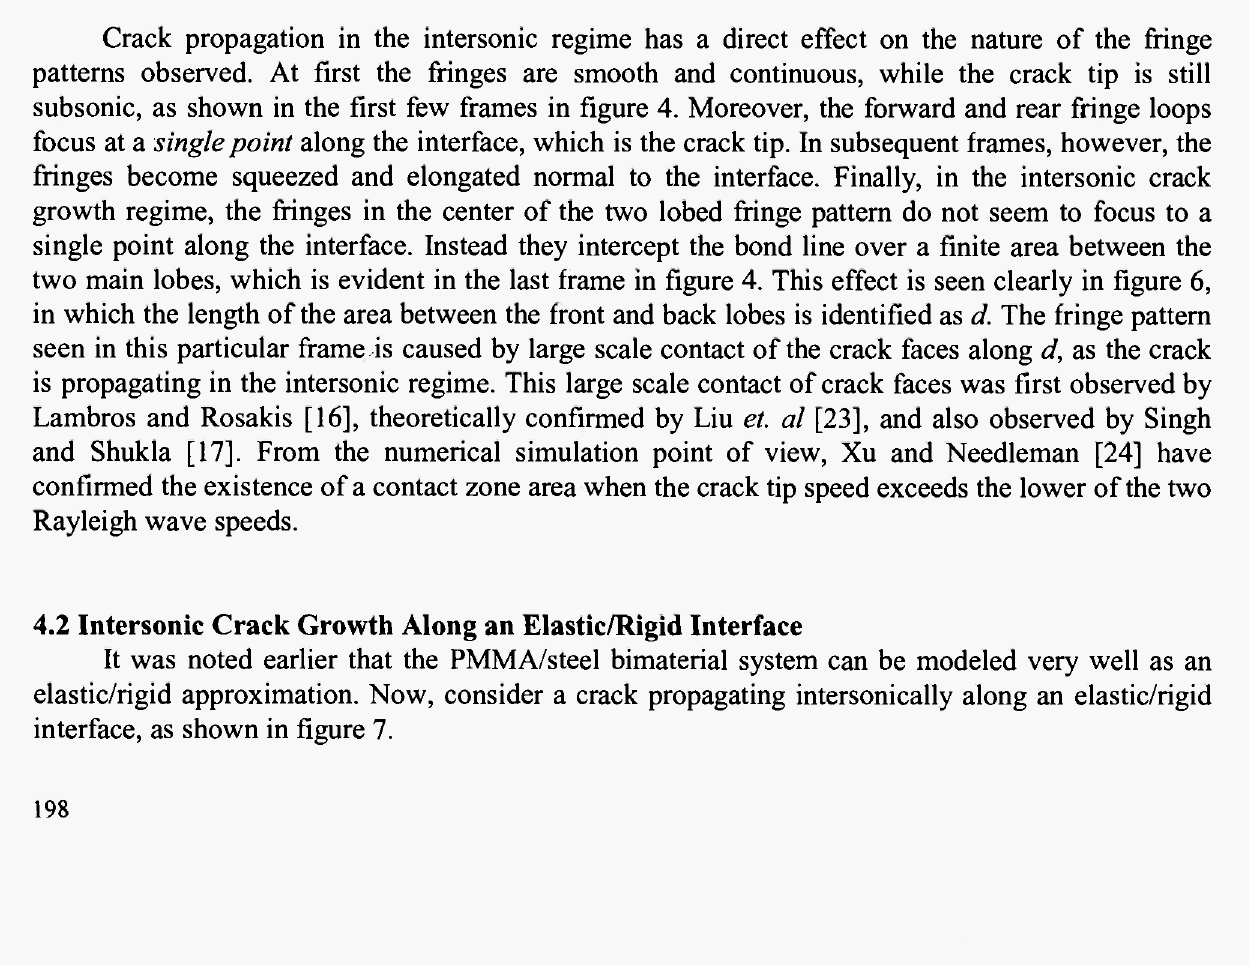
Figure 6: Enlarged view of CGS fringes in the intersonic crack growth regime showing the area of crack face